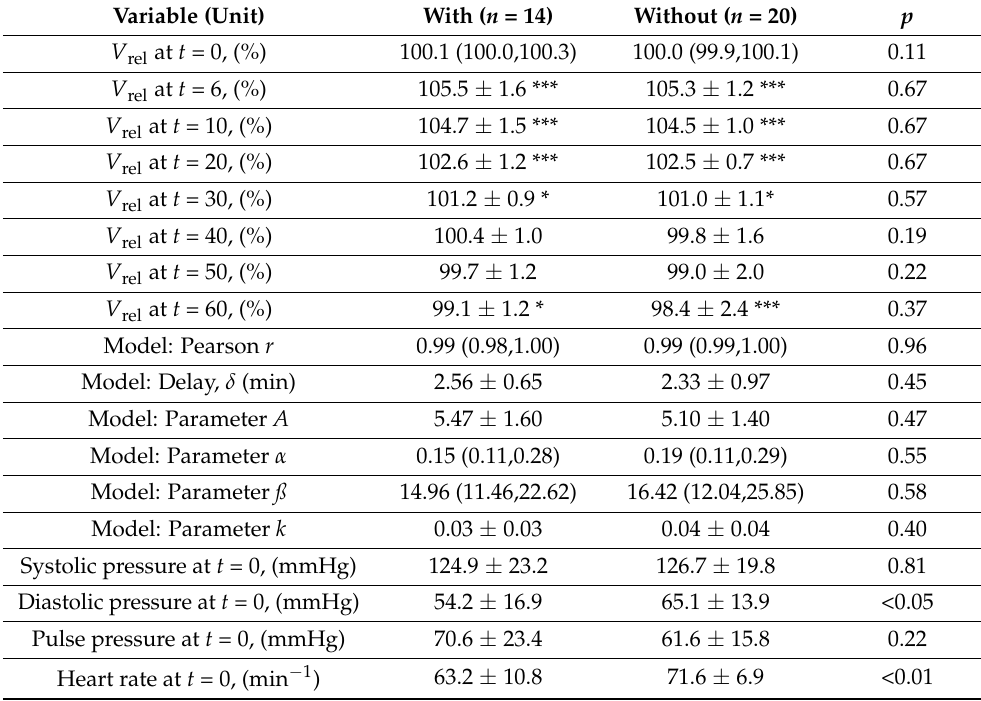
Figure 1. Relative hemodilution. Relative blood volume ( V rel ± SD) in subjects without (closed symbols, n = 20) and with (open symbols, n = 14) T2D, relative to V rel,0 = 100% at the time of glucose injection ( t = 0). T2D, type-2 diabetes mellitus. Table 2. Hemodynamic variables and model parameters in subjects with and without T2D.